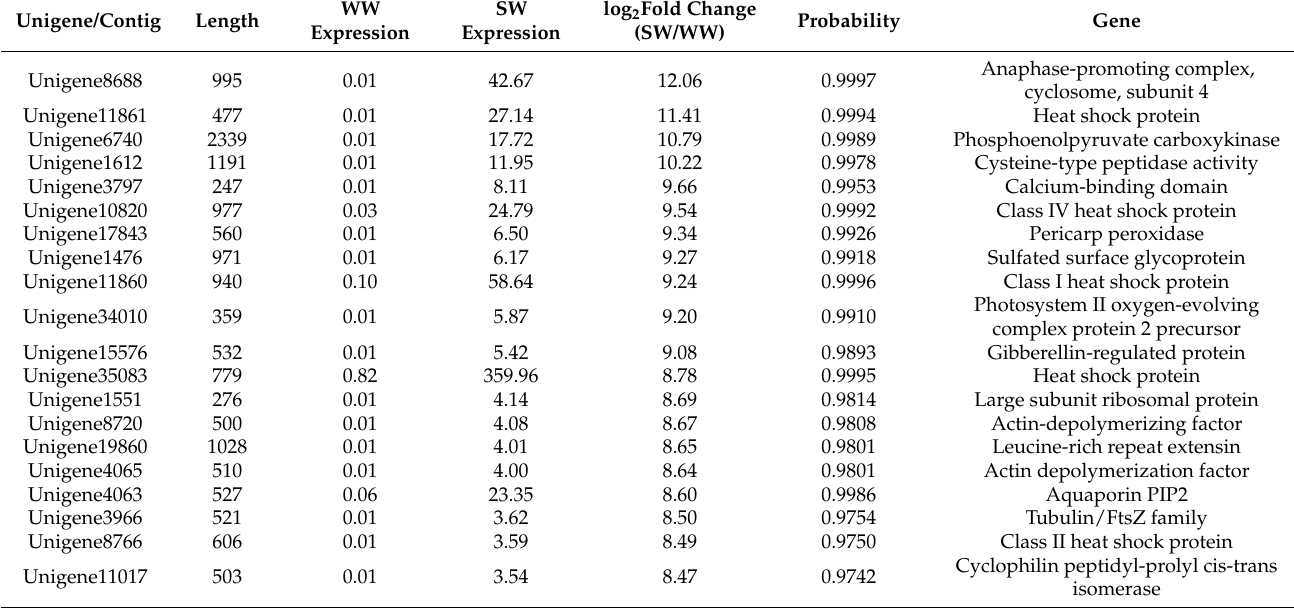
Table 2. List of top 20 upregulated known